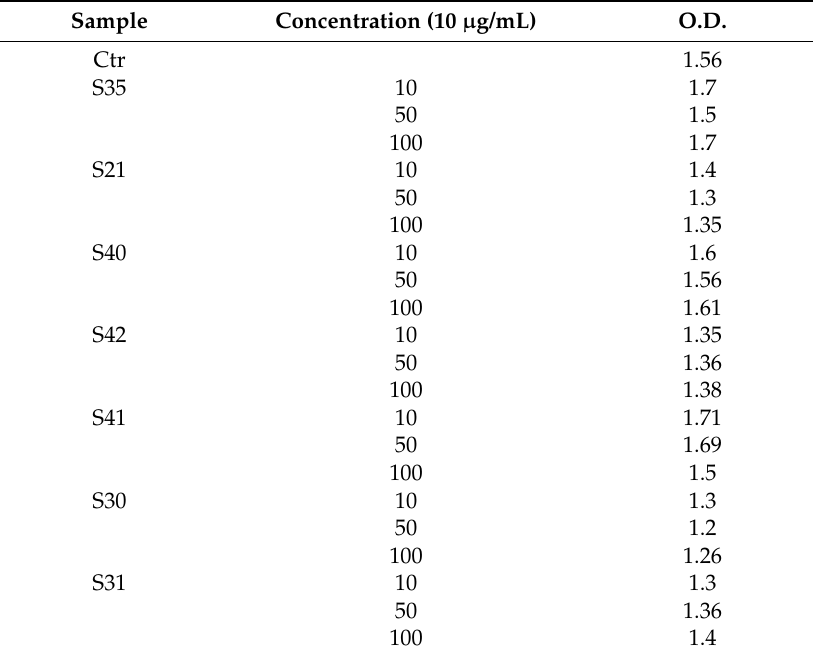
Table 1. Optical density (O.D.) reading at 570 nm resulting from the MTT assay.